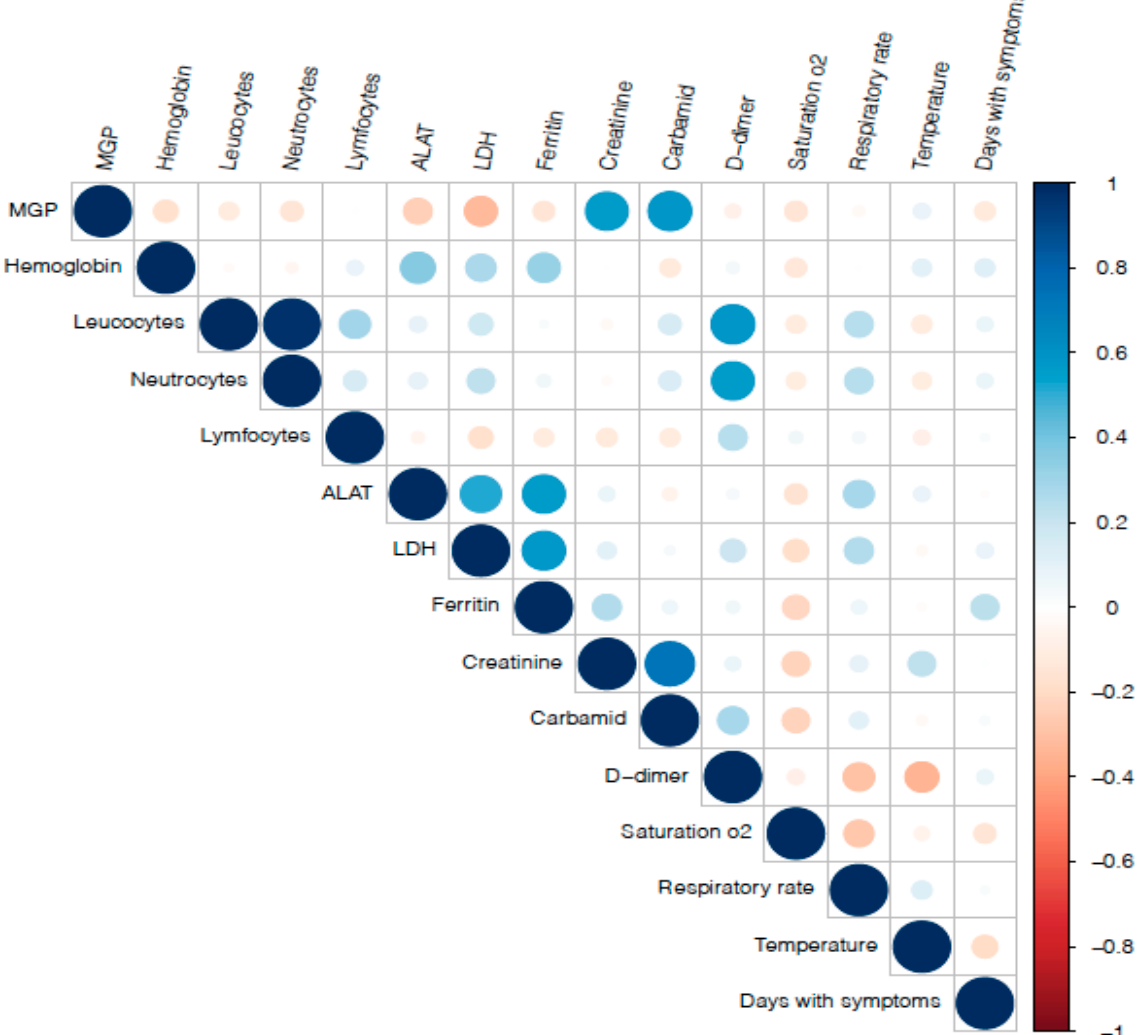
Figure 3. A correlation matrix of measured blood biomarkers and clinical parameters in hospitalized COVID-19 patients. Blue and red colored circles represent positive and negative correlations, respectively. The size of circles reflects the strength of the correlations.